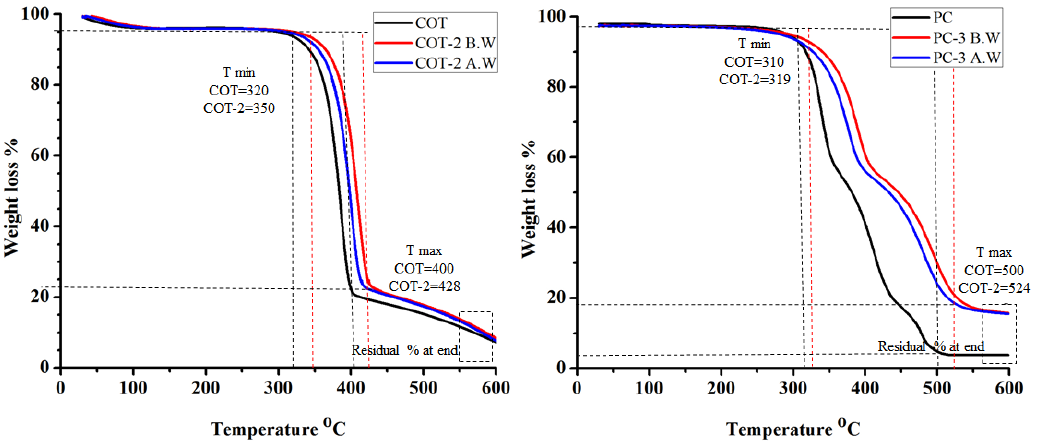
Figure 4. Thermogravimetric analysis of ( a ) untreated (COT, PC) and ( b ) treated fabric samples (COT 2 and PC 2).